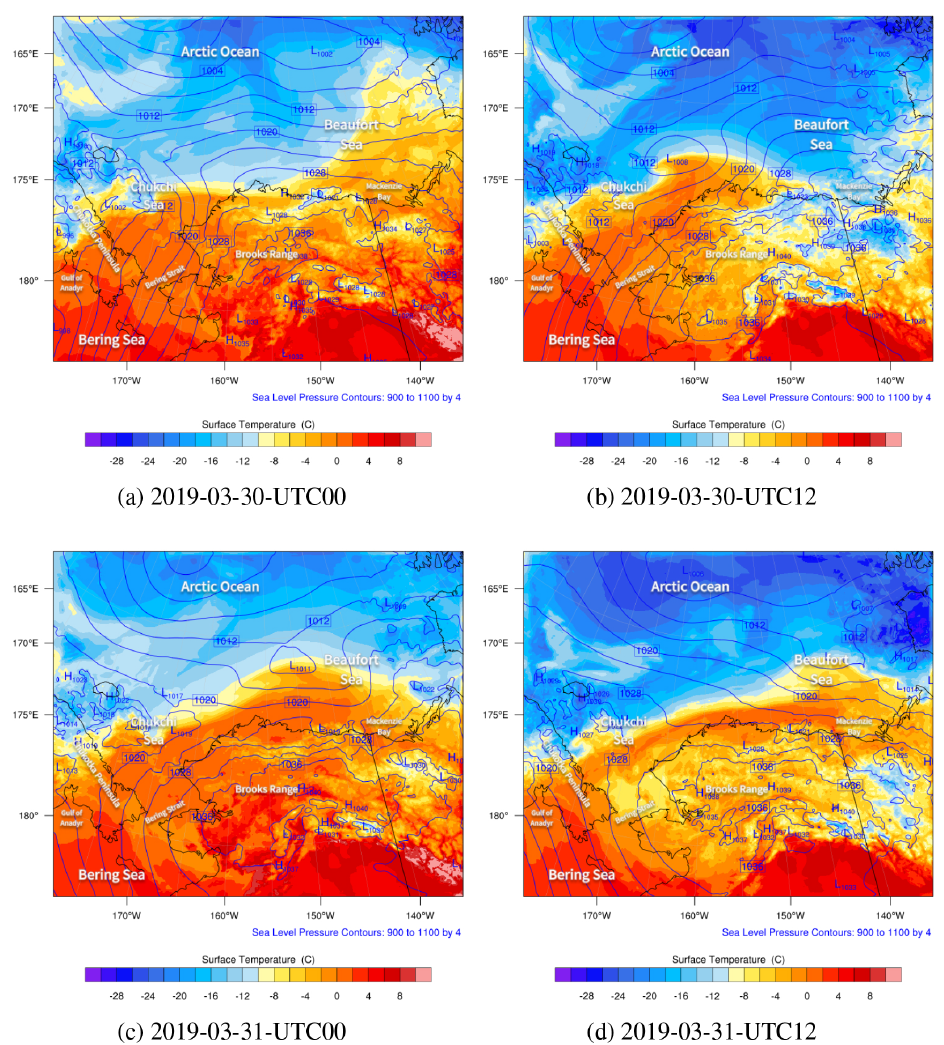
Figure 5. The spatial distributions of the sea level pressure (hPa; contour lines) and surface temperature ( ◦ C; contour fills) simulated by WRF from 30 to 31 March